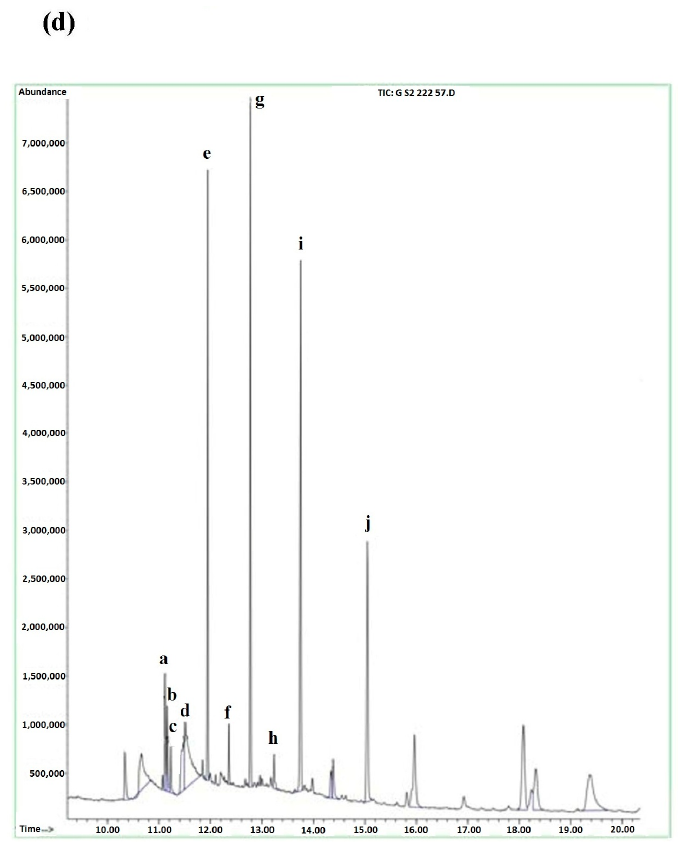
Figure 1. ( a ) Free radical scavenging activity of the ethanol extract of R. coriaria measured by ABTS assay. Results are expressed as mean ± SEM ( n = 3); ( b ) effects of the R. coriaria ethanol extract on DPPH scavenging activity; ( c ) results of the β -carotene bleaching assay of the R. coriaria ethanol extract; ( d ) GC-MS chromatogram of the R. coriaria ethanol